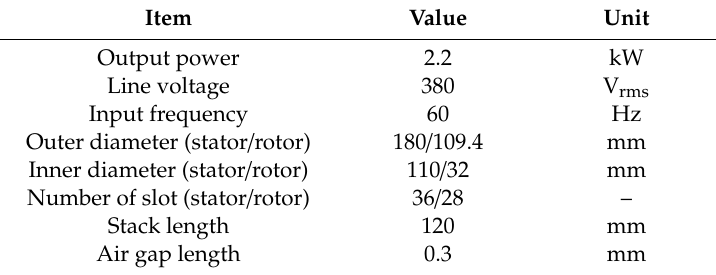
Figure 4. Finite element analysis (FEA) model of reference machine. Table 1. Specification of reference machine.